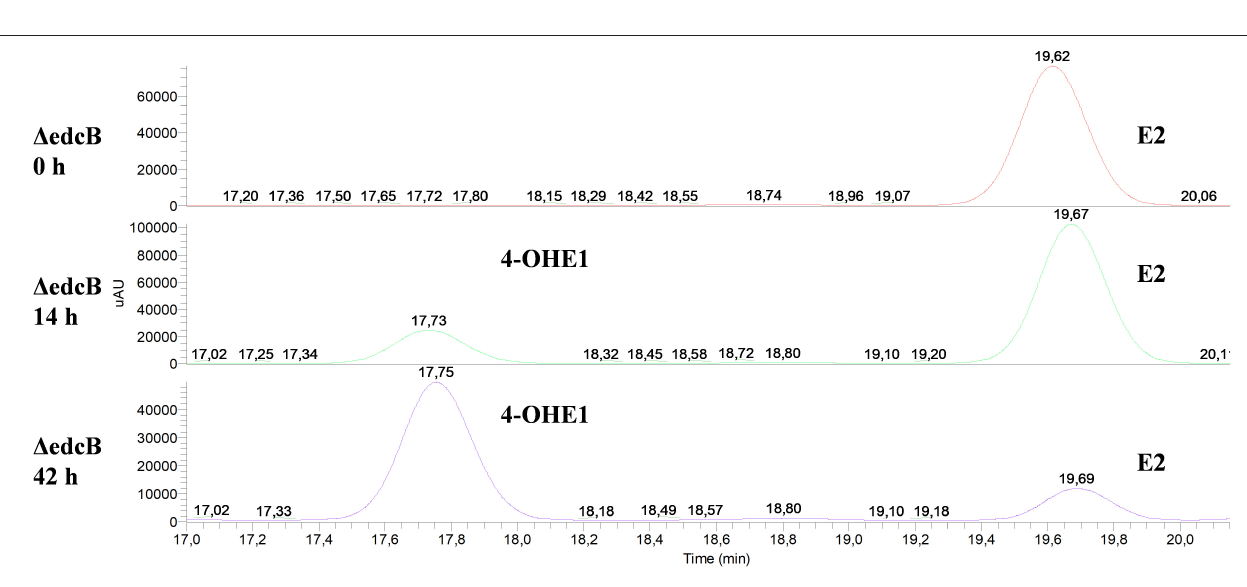
FIGURE 8 | HPLC-MS analysis of the organic phase extracted from cultures of N. tardaugens 1 edcB in NB rich medium supplemented with 2mM E2. UV chromatograms at 282nm of the samples at 0, 14, and